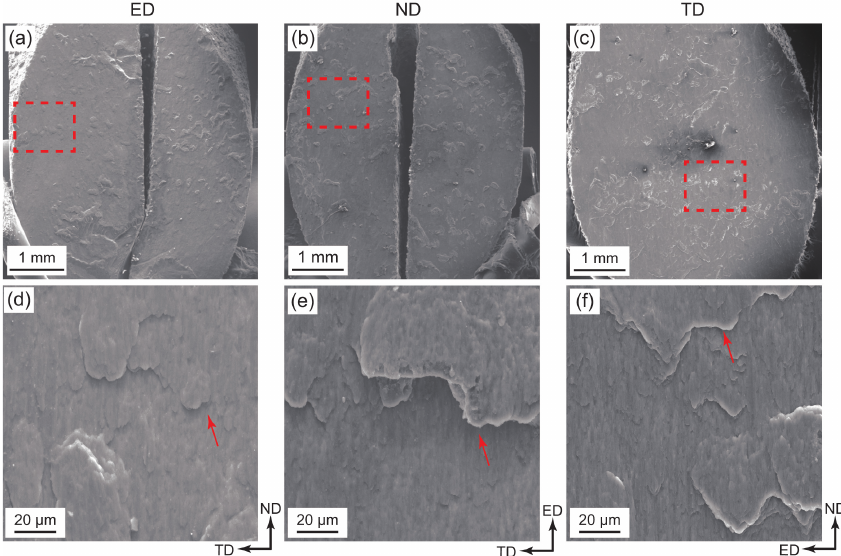
Figure 6. SEM fractographs of the postmortem specimens for quasi-static compression at 10 − 3 s − 1 along ( a ) ED, ( b ) ND and ( c ) TD. ( d – f ) are magnified views of the regions indicated by the rectangles in ( a – c ), respectively. The scaly features are pointed out by red